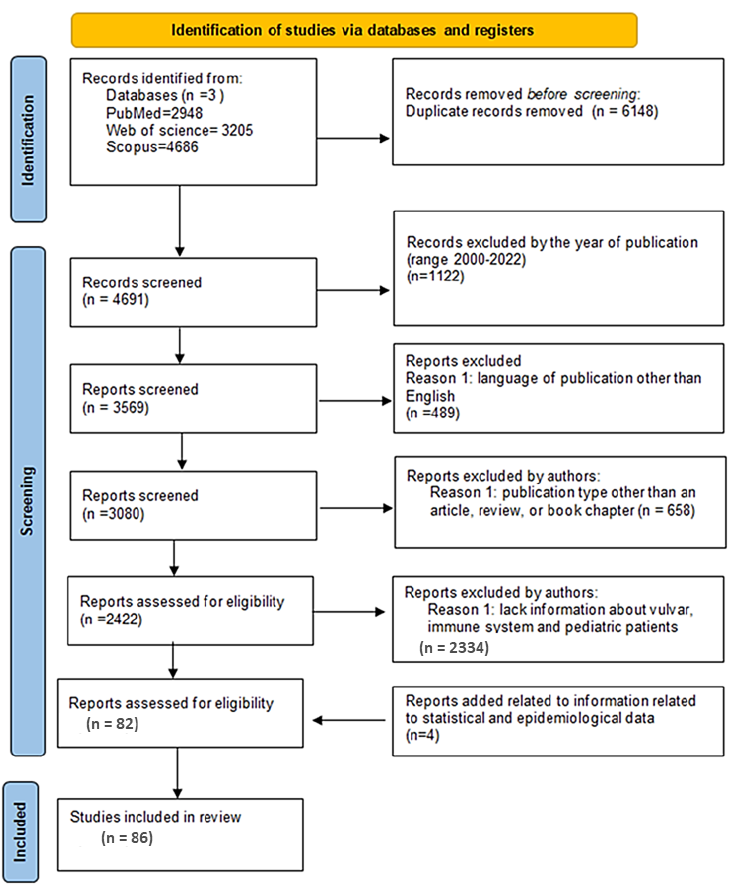
Figure 1. PRISMA flow chart illustrating the selection process for articles for this review.